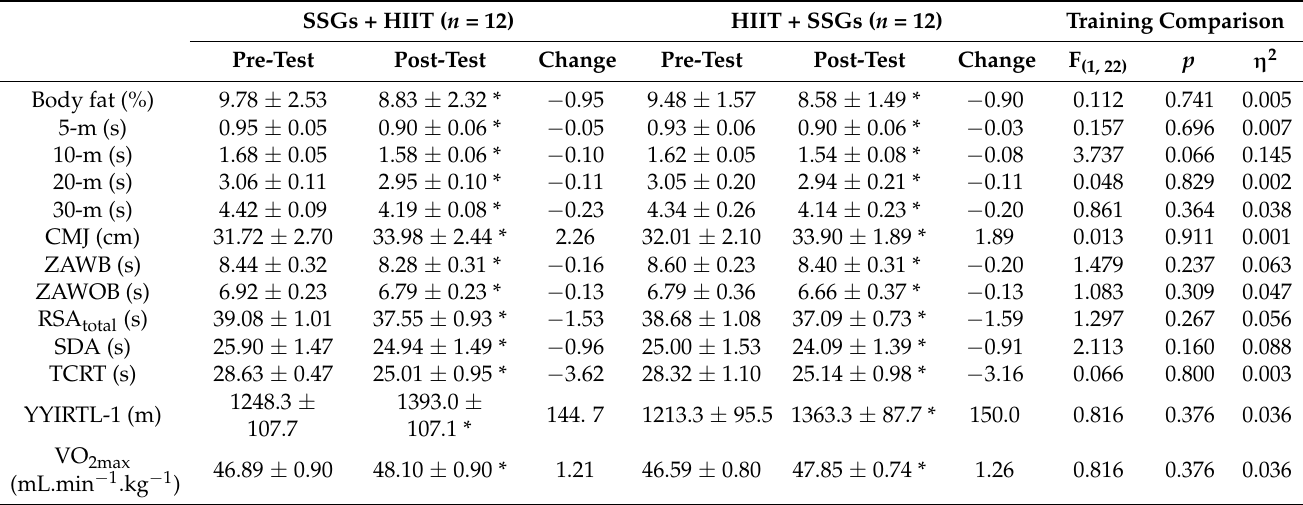
Table 2. Effect of both training methods on physical and technical performances of the participants. SSGs + HIIT ( n = 12) HIIT + SSGs ( n =